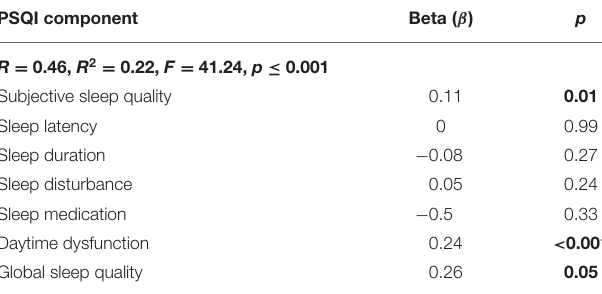
TABLE 3 | Associations between seven PSQI components and global sleep quality score on depression.